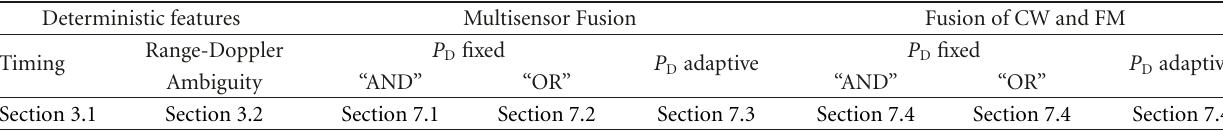
Table 2: Overview of di ff erent versions of the multistatic